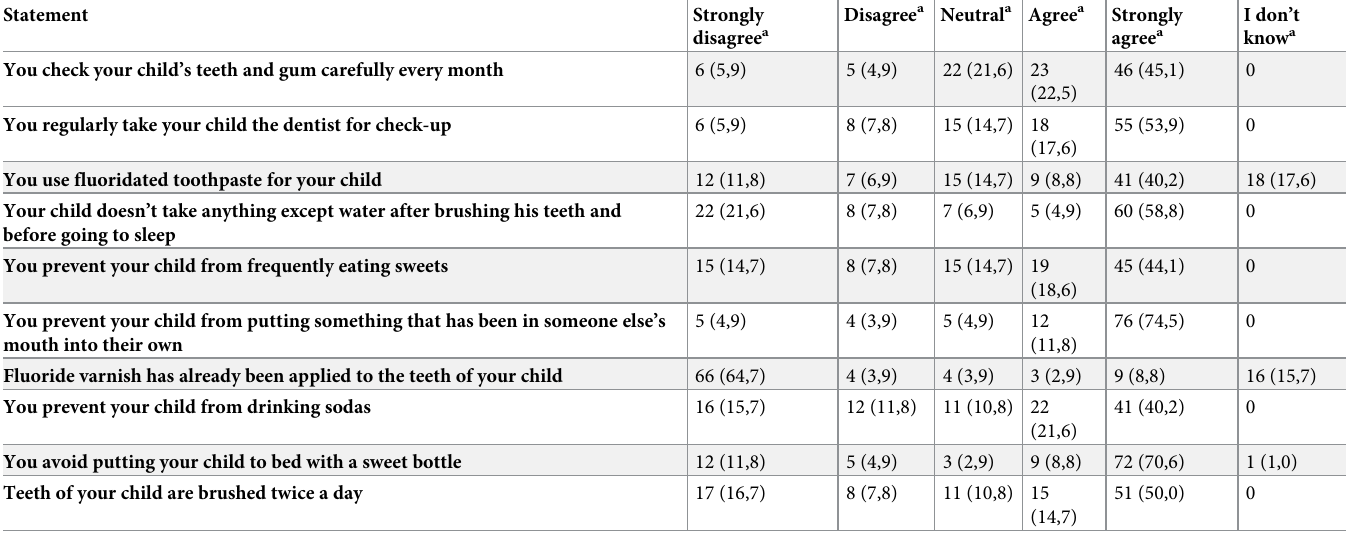
Table 3. Parental oral health